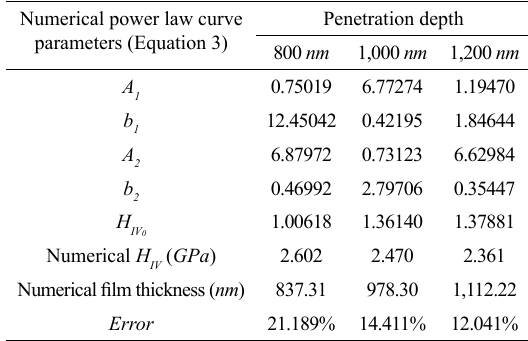
Table 6. Comparison between numerical hardness obtained from initial penetration depth estimates.